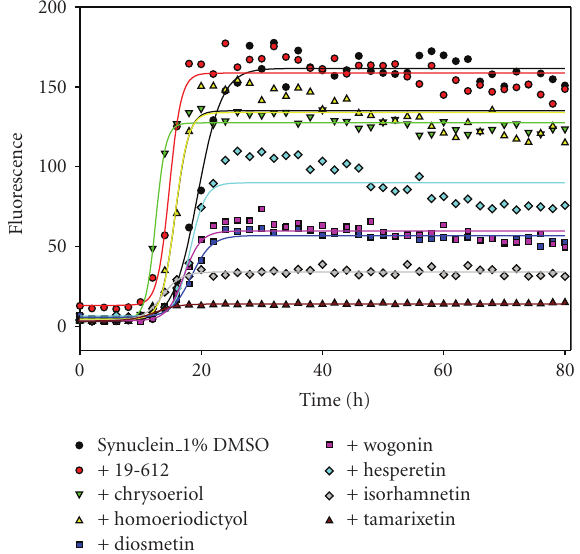
Figure 3: The kinetics of α -synuclein fibrillation in the presence of noninhibitory flavonoids by ThT plate reader assays. Each curve was obtained by fitting the data with Sigma Plot, using the equation from [61].